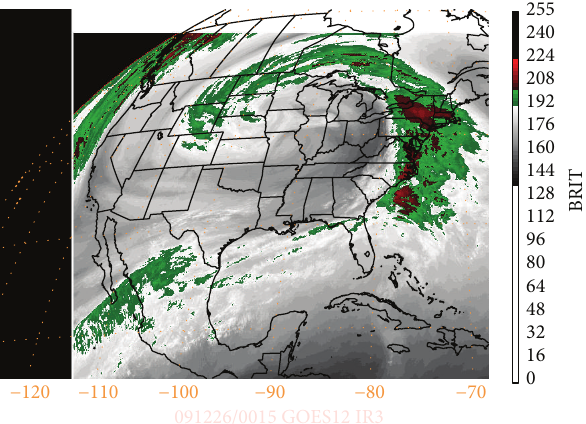
Figure 4: As in Figure 1(c), except for 0015 26 December